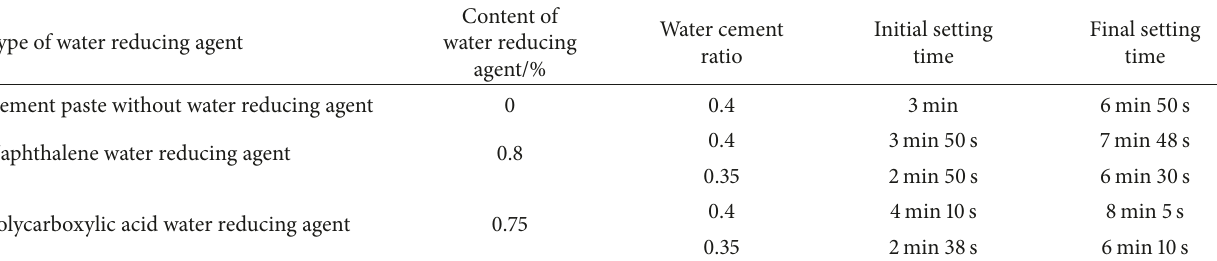
Table 4: The adaption of accelerator to water reducing